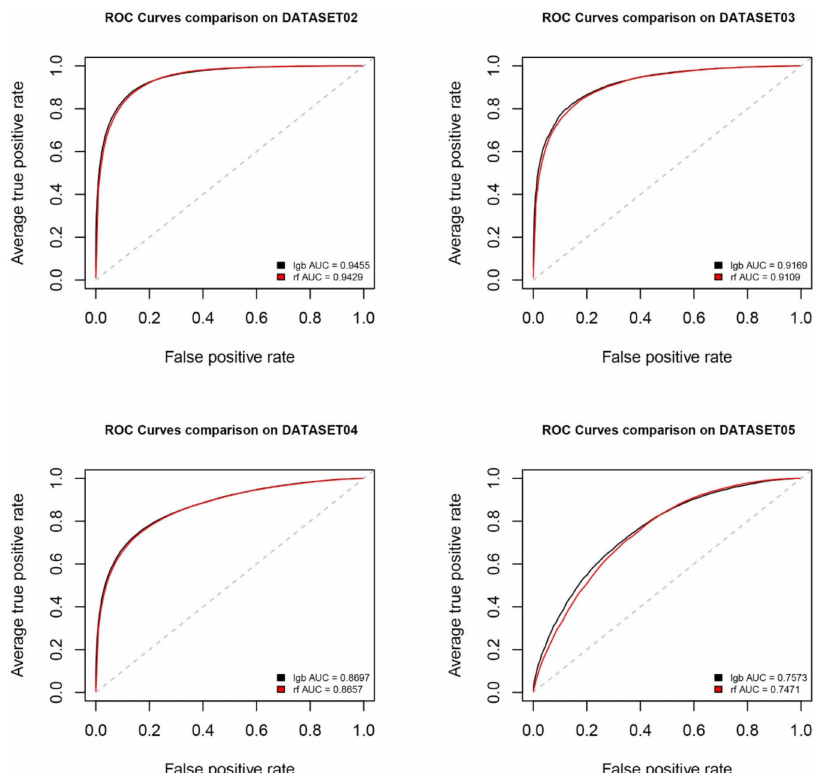
Figure 6. ROC curves displaying the performance comparison between LightGBM (lgb) and random forest (rf) on a training dataset of DataSet 01.